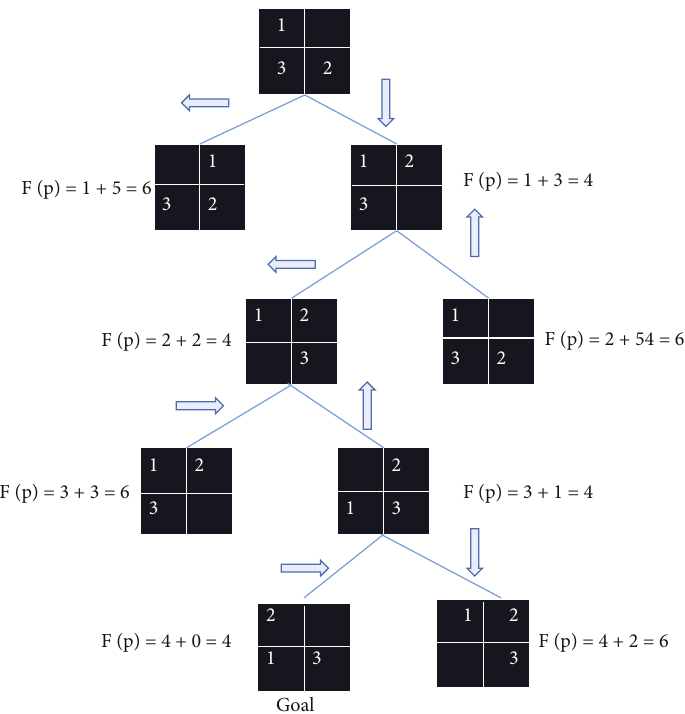
Figure 4: Three digital